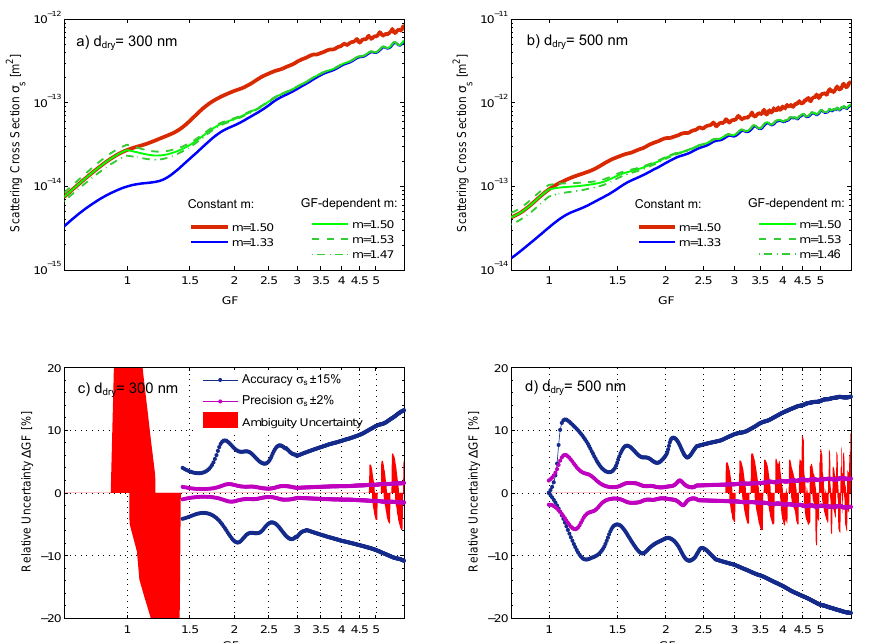
Figure 9. Optical sizing of solution droplets. Panels (a) and (b) show theoretically calculated scattering cross sections versus growth factor (solid green lines) for the example of particles with a dry index of refraction of 1.50 and dry diameters of 300 and 500nm, respectively. The solid red and blue lines are theoretical curves for particles with a constant index of refraction, and the green lines indicate the effect of a calibration bias (see text for details). Panels (c) and (d) display the sizing uncertainties due to different causes for the example particles from panels (a) and (b) , respectively.